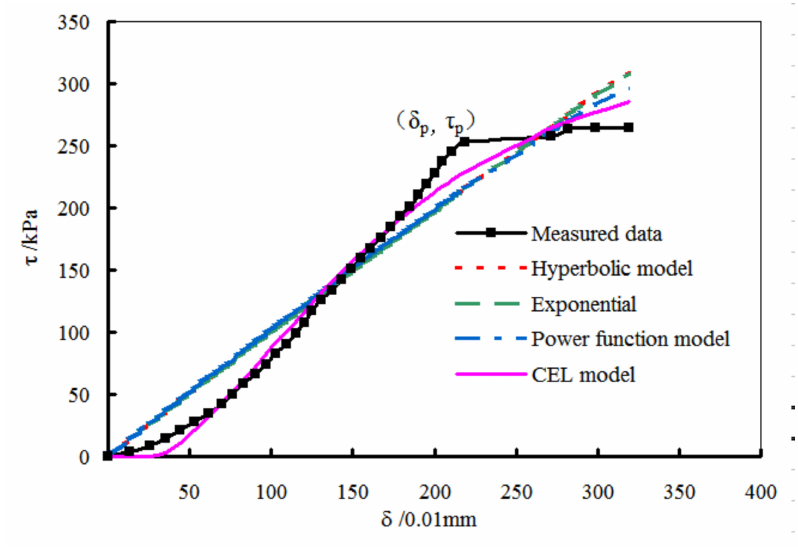
Figure 12. τ - δ curve under 400 kPa vertical